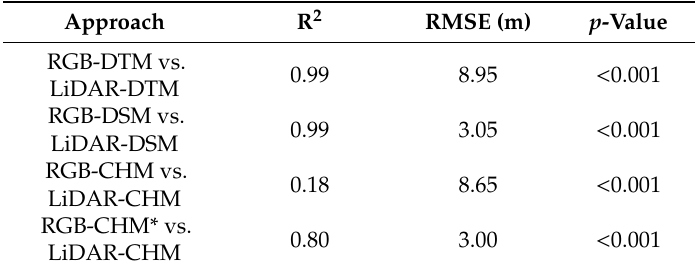
Table 1. AGB validation comparing RGB models with the LiDAR models.